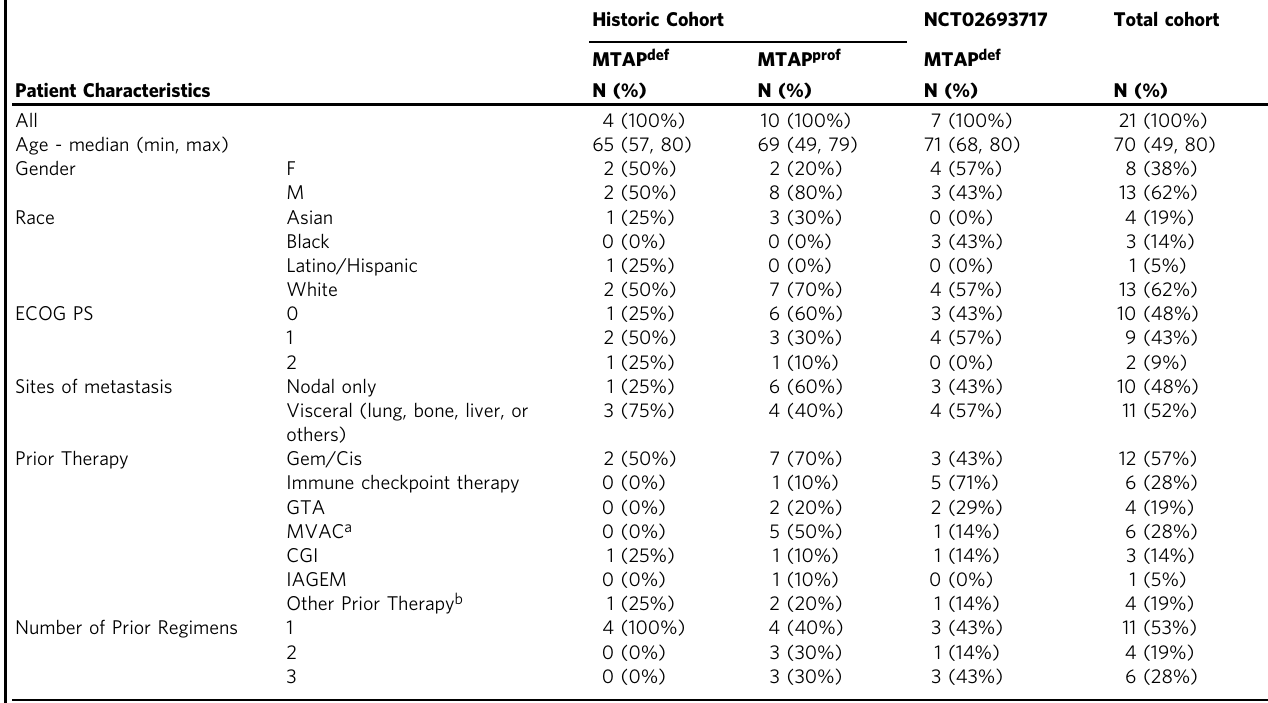
Table 1 Baseline patient characteristics of patient with metastatic urothelial cancer at the start of pemetrexed treatment. Historic